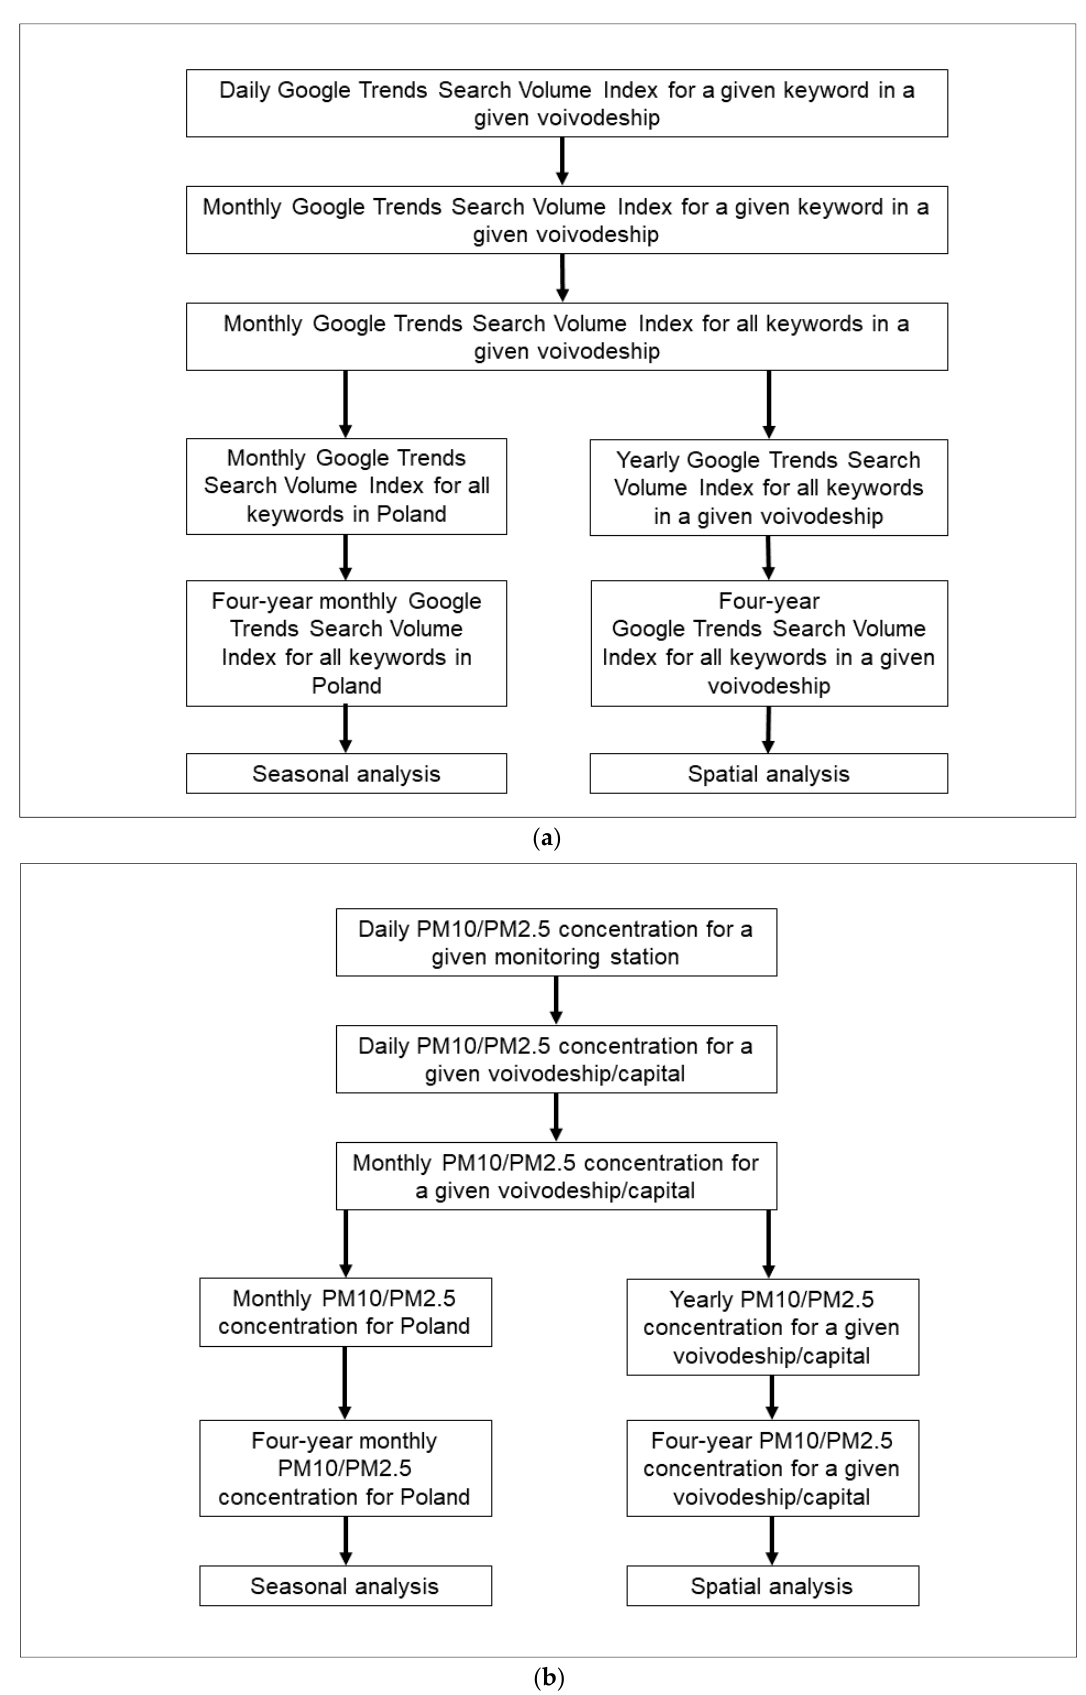
Figure 3. Methodology of GTSVI data synthesis ( a ) and air quality data synthesis ( b ). In addition to that, the mean number of monitoring stations per voivodeship, mean area per monitoring station, mean population per monitoring station and mean popula- tion density per monitoring station were computed (Tables 2 and 3).